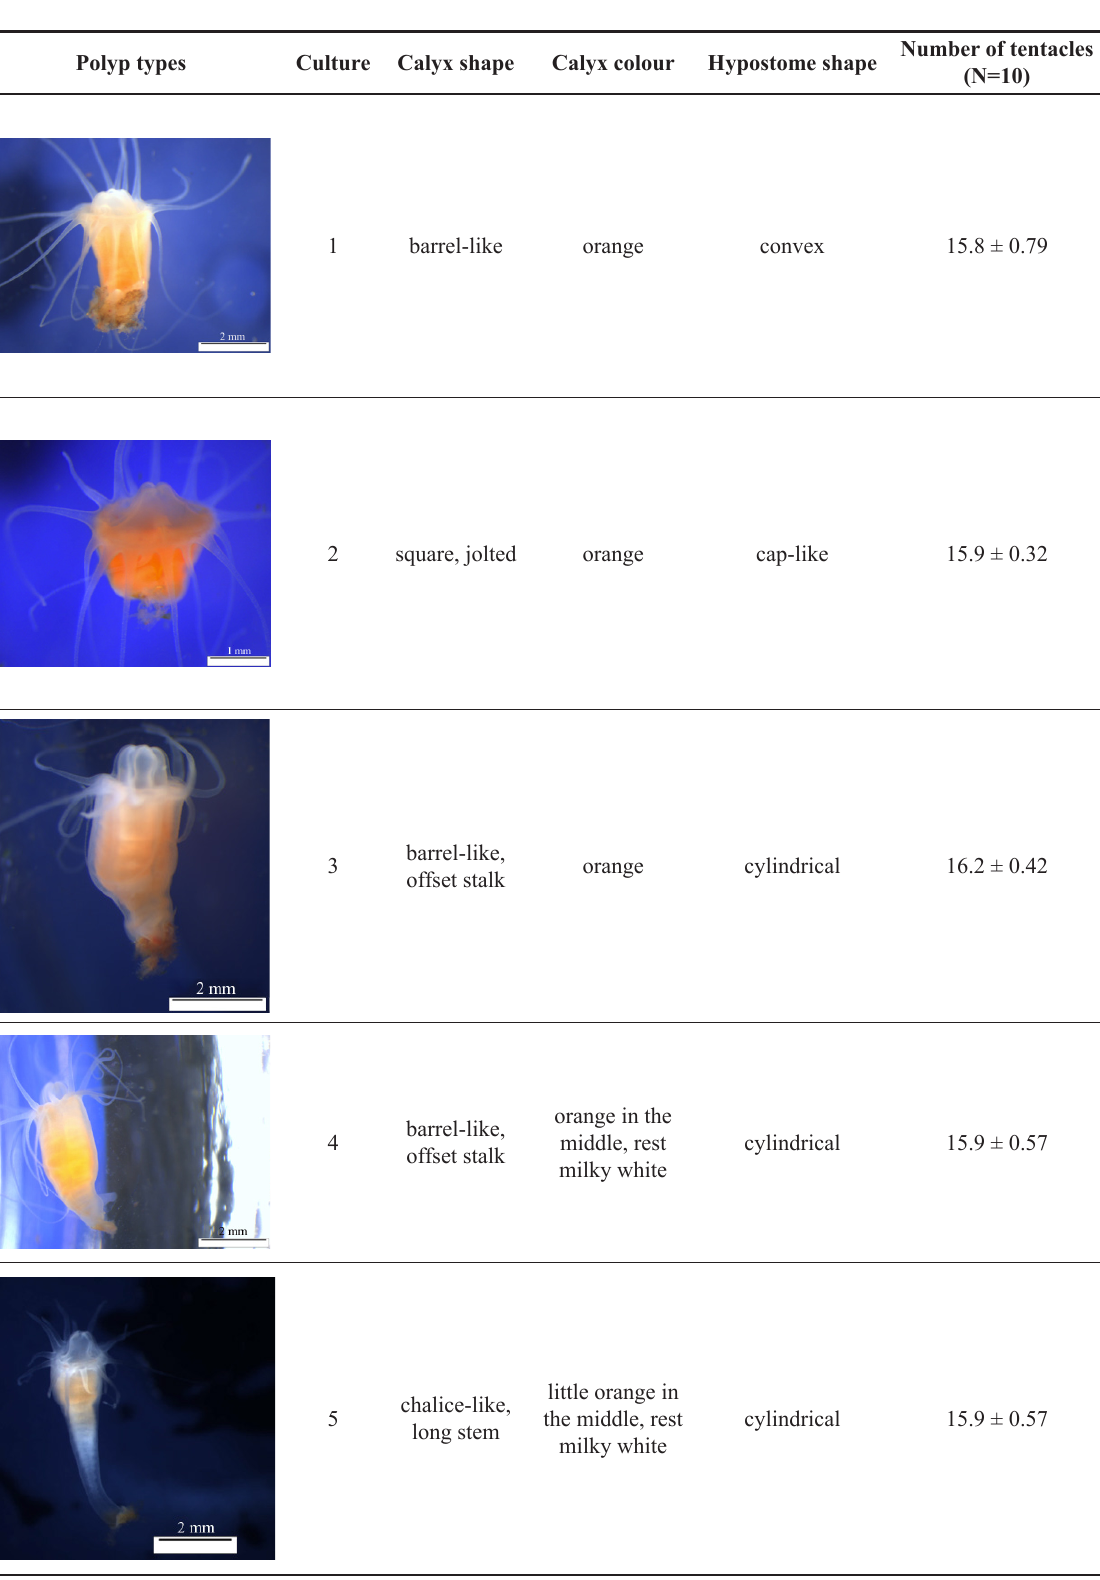
Table 3. Collected morphological features of the scyphistomae of Aurelia sp.; tentacles were counted on 10